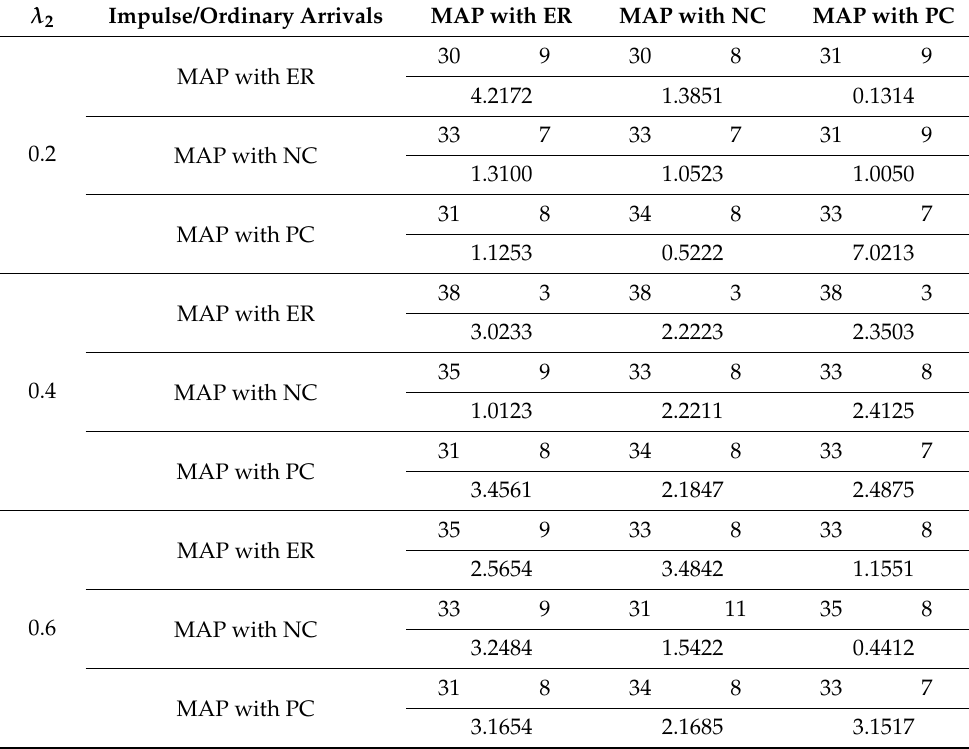
Table 11. Effects of λ 2 with various